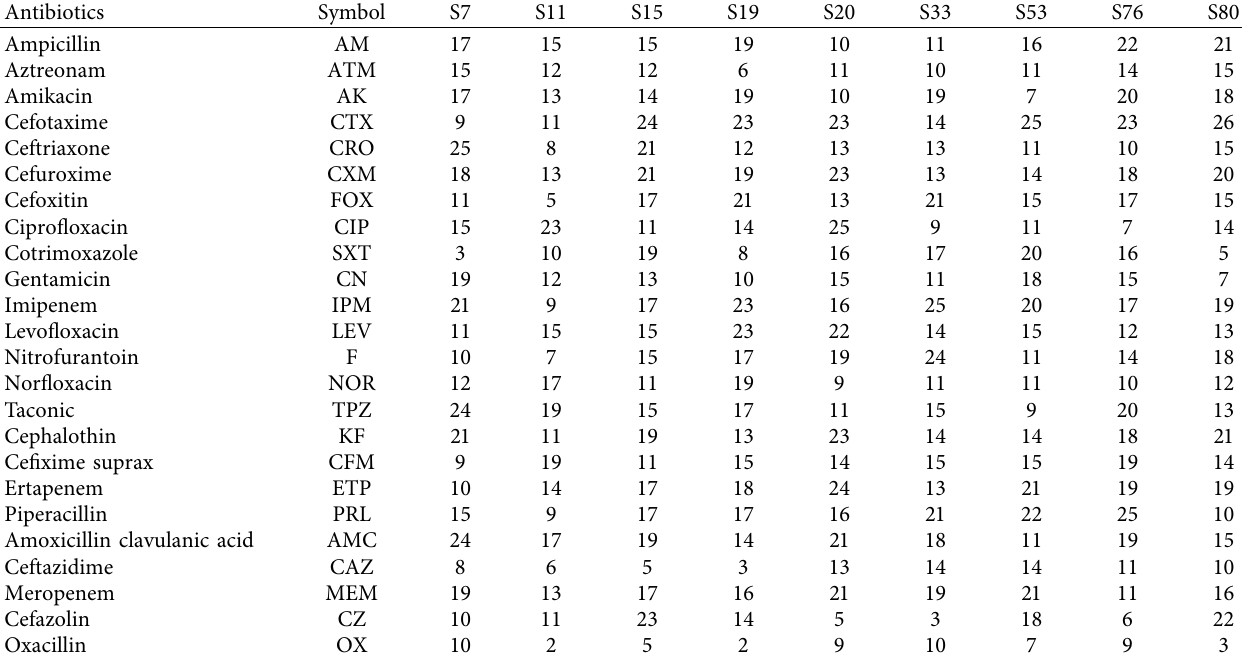
Table 11: Te antibiotic sensitivity diameters per (mm).